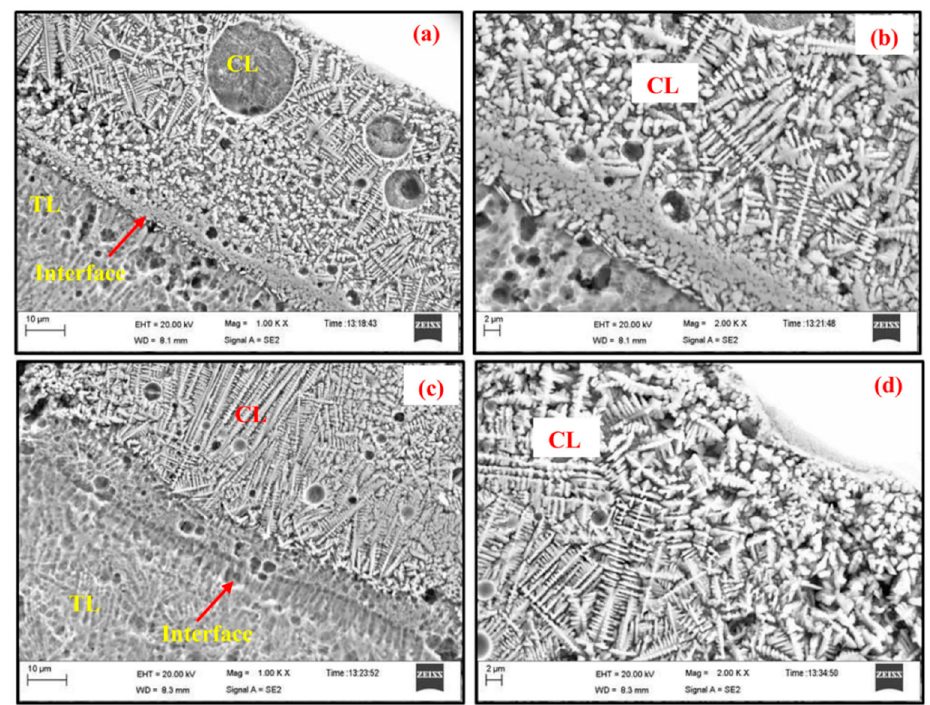
Figure 13. Cross-sectional morphology of 100% HA and functionally graded material (FGM) laser cladding at laser energy density (LED) 21.6 J / mm 2 ( a , c ) interface between the crust layer (CL) and the transition layer (TL) (low magnification) and ( b , d ) CL (high magnification) [90]. The top layer of cladding is identified as CL. Beneath the CL, the TL is present, where transition of elements between cladding and substrate occurs. Reprinted with permission from reference [90] 2018 Elsevier.